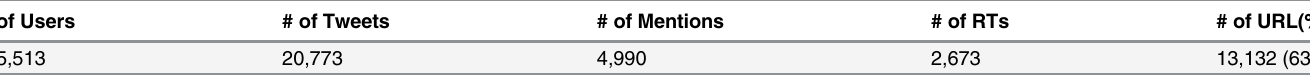
Table 1. Summary of the Twitter dataset used in this